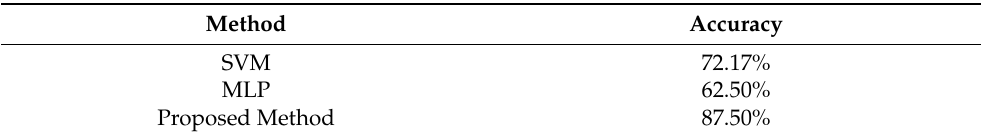
Table 1. Comparative analysis of the accuracy of the proposed method support vector machine (SVM) and multilayer perceptron (MLP).